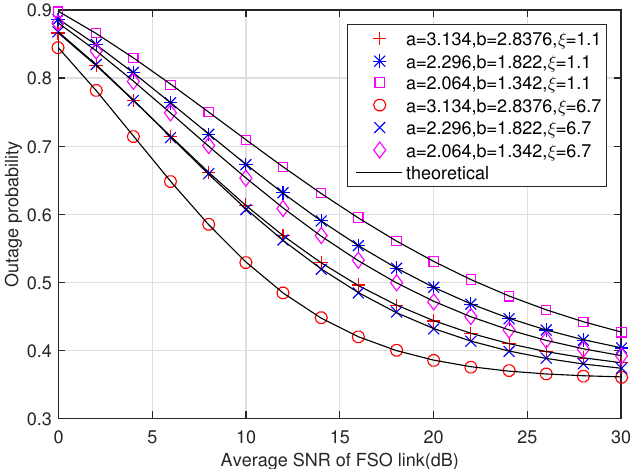
Figure 3. Outage probability under different turbulence and pointing error conditions with IM/DD detection.